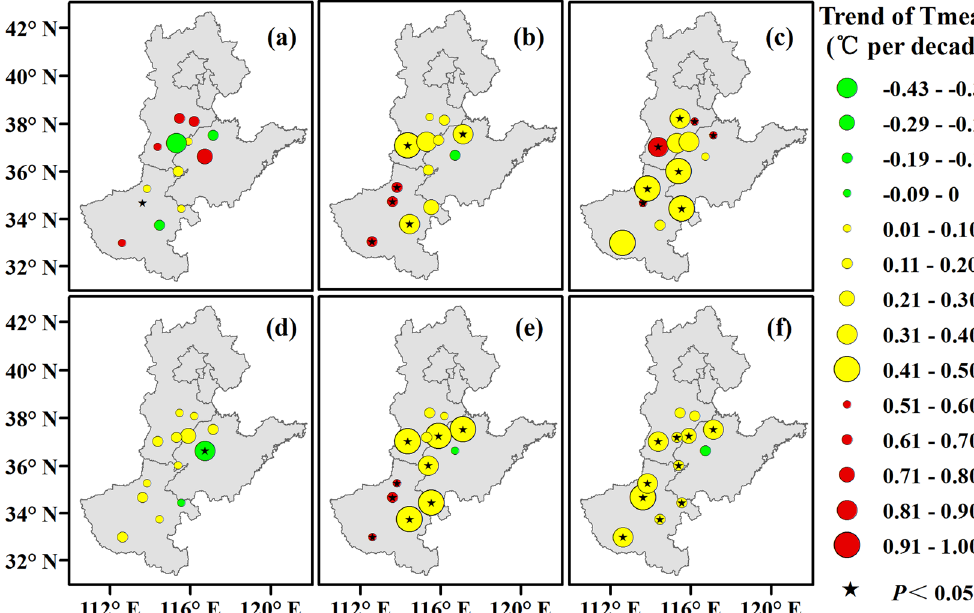
Figure 4. Trends in Tmean during the sowing-emergence ( a ), emergence-squaring ( b ), squaring-flowering ( c ), flowering-boll opening ( d ), and boll opening-harvest ( e ) periods and the whole growing period ( f ) of cotton across the North China Plain from 1981 to 2012. Green, yellow, and red circles represent the trends of the Tmean. Black pentagrams represent a significance level of 0.05. Maps were generated using ArcGIS 10.1 (ESRI Inc, Redlands, CA, USA, http://www.esri.com/).